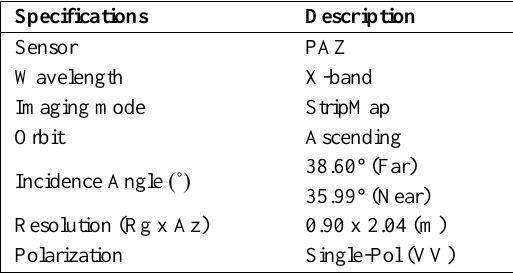
Table 1. Specifications of PAZ